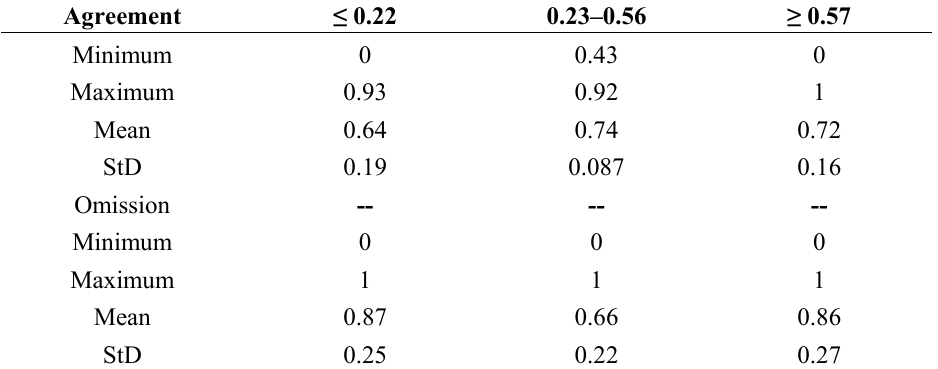
Table 4. Summary statistics on agreement and omission rates for three strata of NDVI from L5LSRP at all unobscured EDEN gages on every image date. StD = standard deviation. Areas of low vegetation cover exhibit comparable statistics to the high cover class.